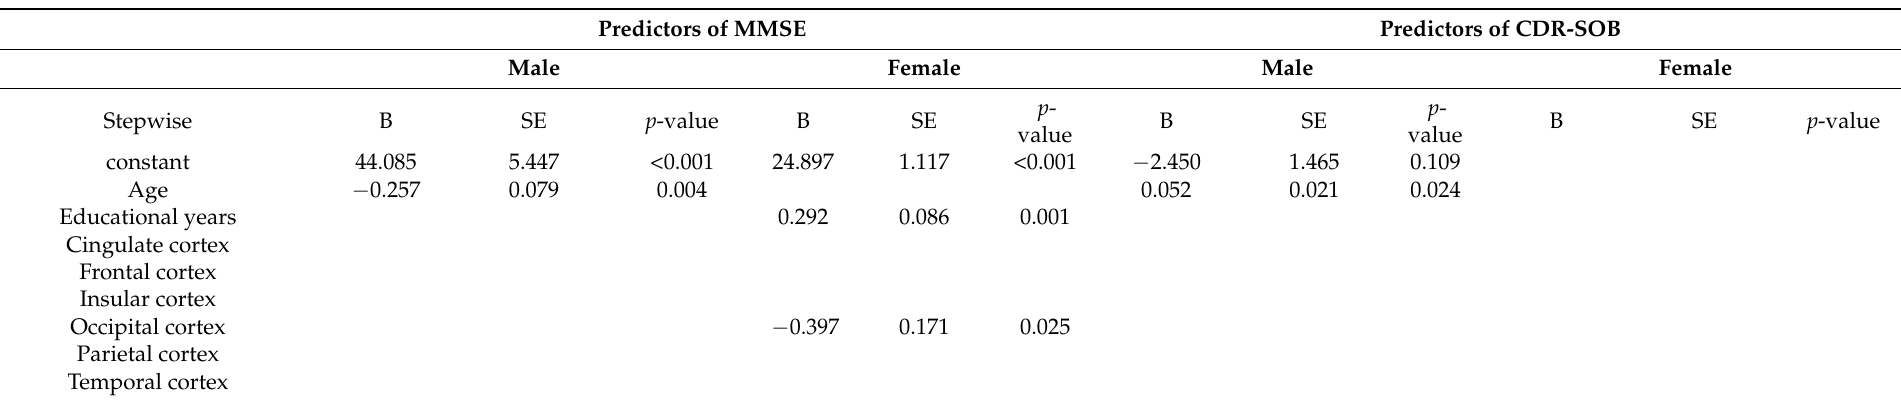
Table 5. Predictors of MMSE and CDR-SOB scores in the MCI